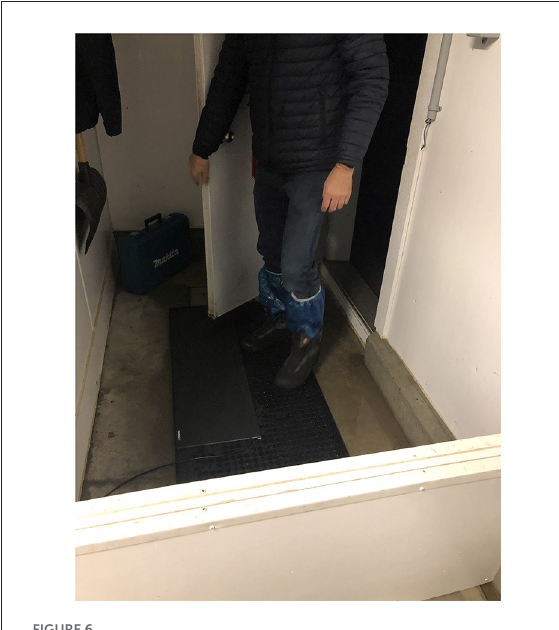
FIGURE6 Dirty area of the turkey barn (pressure mat and antenna located on the floor)—Maximus prototype.